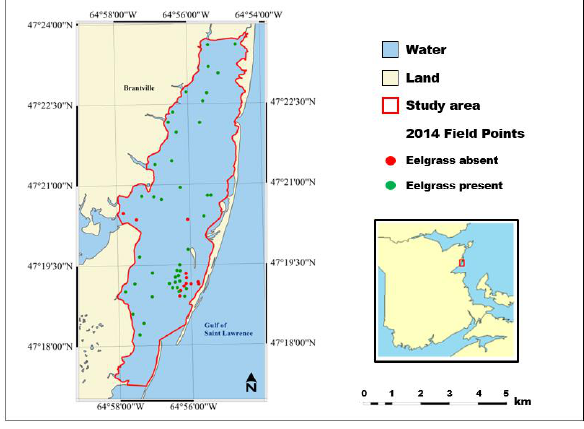
Figure 1. Location of the Tabusintac Bay and the eelgrass presence/absence GPS points of 2014 collected by (Stantec (2014) and used in this